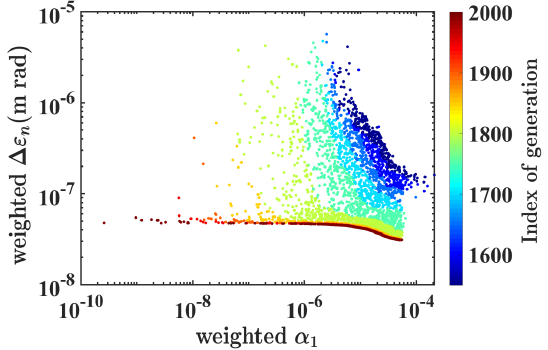
FIG. 5. Objective functions of the last 500 generations.